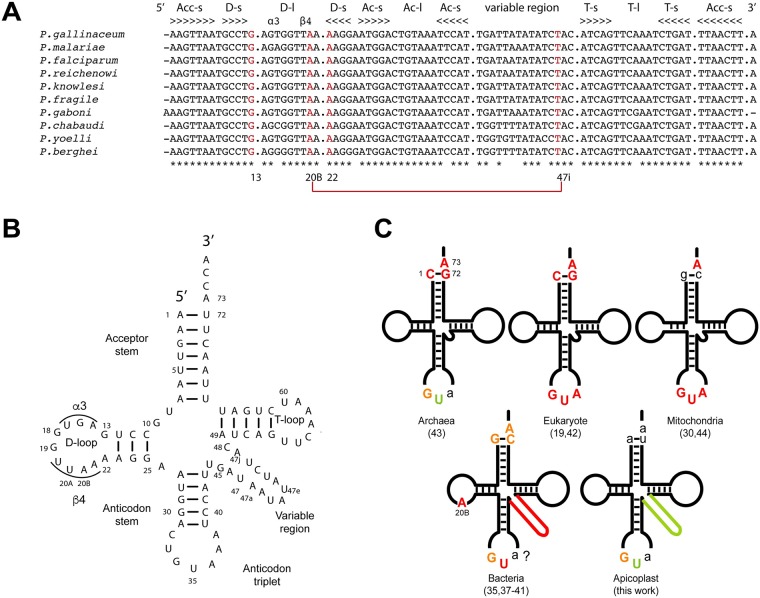
Sequence of Pf-apitRNATyr and evolution of tyrosine identity.(A) Comparison of tyrosine-specific apicoplast tRNAs belonging to different Plasmodia species. The domains of the cloverleaf structure are indicated at the top: Acc-s refers to the acceptor-stem; D-s refers to the D-stem; D-l refers to the D-loop; Ac-l refers to the anticodon-loop; T-s refers to the T-stem; and T-l refers to the T-loop. Structural elements or nucleotides involved in specific tertiary interactions are highlighted in red. (B) Secondary structure of Pf-apitRNATyr. The architectural organization of the D-loop (α and β domains on both sides of residues G18G19) is indicated. Notice the non-canonical G13-A22 base pair located at the end of the D-arm. The tRNA is numbered according to [36]. (C) 2D schematic structures of tRNATyr showing the residues involved in tyrosylation in different phylae [19,30,37–44]. The residues involved in tyrosine identity are explicitly given in uppercase. The strengths of the tyrosine identity elements are indicated by colors: red (loss in catalytic efficiency >100-fold compared to the wild-type transcript), orange (loss between 10- and 100-fold) and green (loss between 5- and 10-fold). Lowercase letters are given to highlight conservation of the residues in the anticodon triplet and at positions 1–72 and 73 in the acceptor stem, despite their exclusion from the identity set. The question mark shows that the importance of position 36 has not been tested in bacteria.